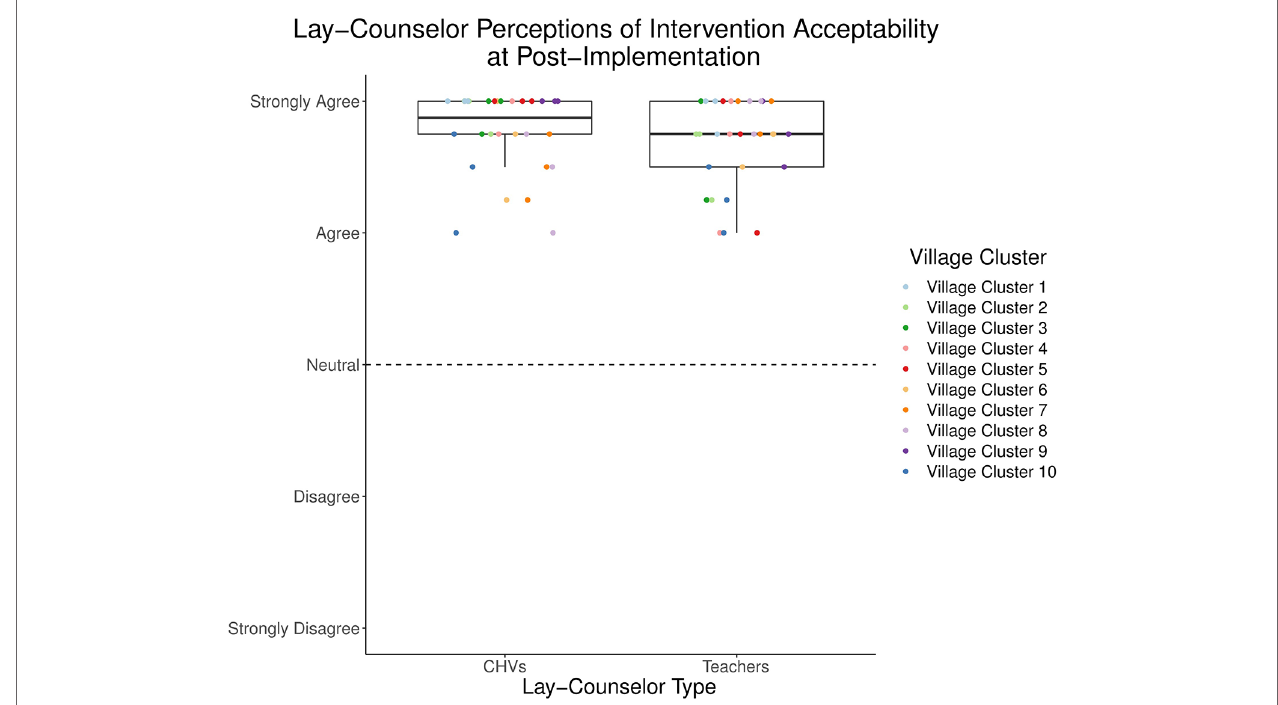
FIgUrE 2 | Lay counselor perceptions of intervention acceptability at